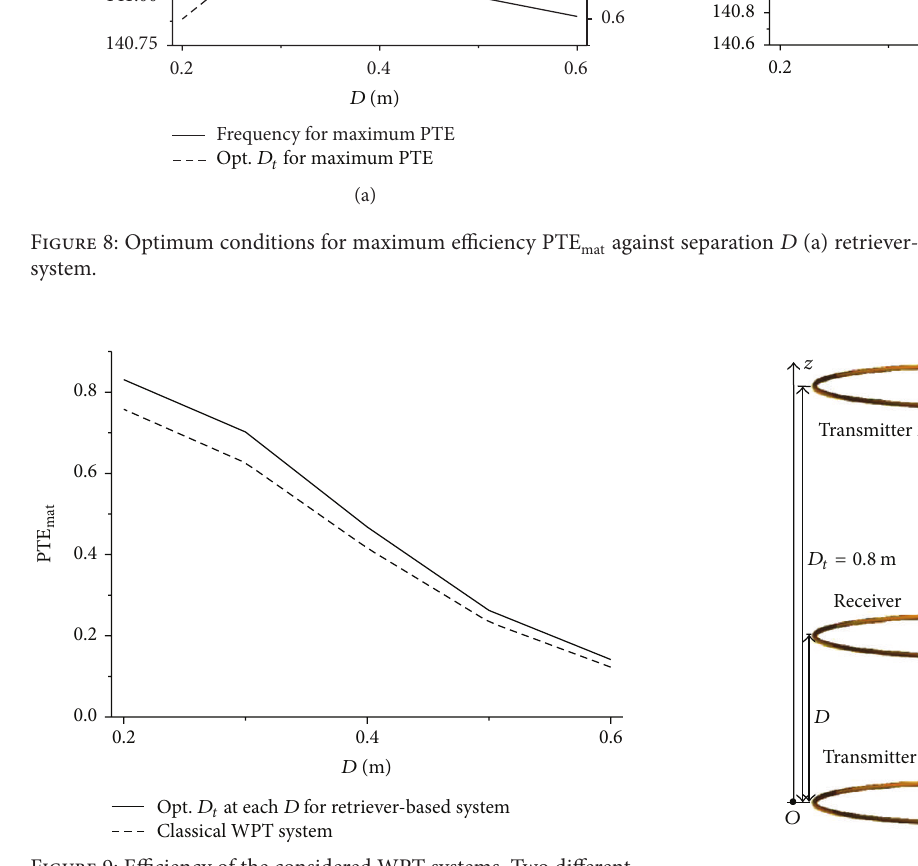
Figure 9: Efficiency of the considered WPT systems. Two different Figure 10: System schematic of two transmitters and one systems are considered: a WPT system with retriever and distance 𝐷 (solid line); the classical WPT 𝐷 𝑡 optimized for each separation system shown in Figure 5(b) (dashed line).